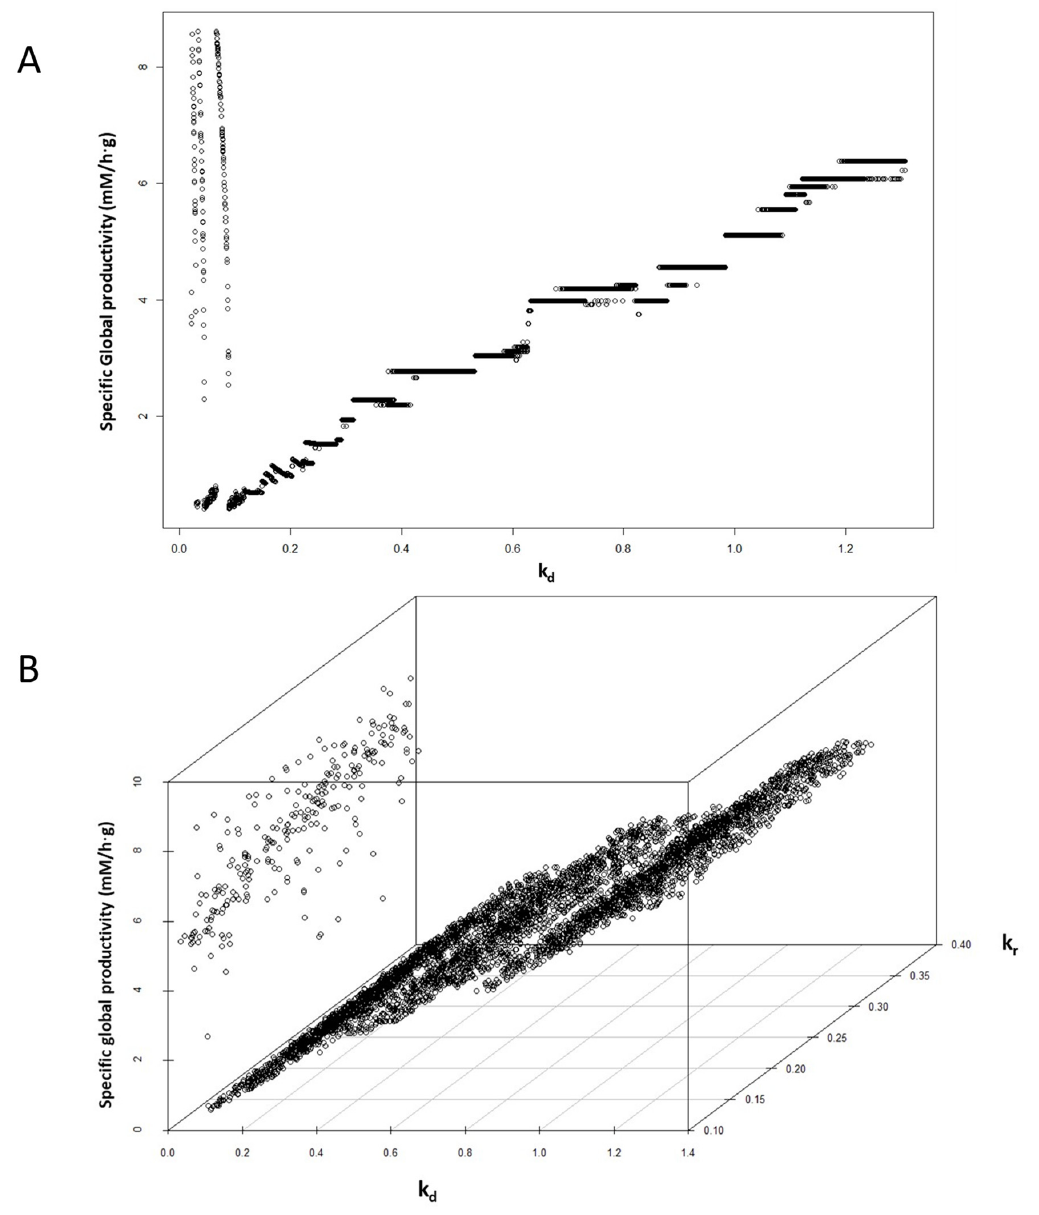
Figure 9. Specific global productivity under di ff erent conditions: ( A ) without inactivation and ( B ) with reactivation.